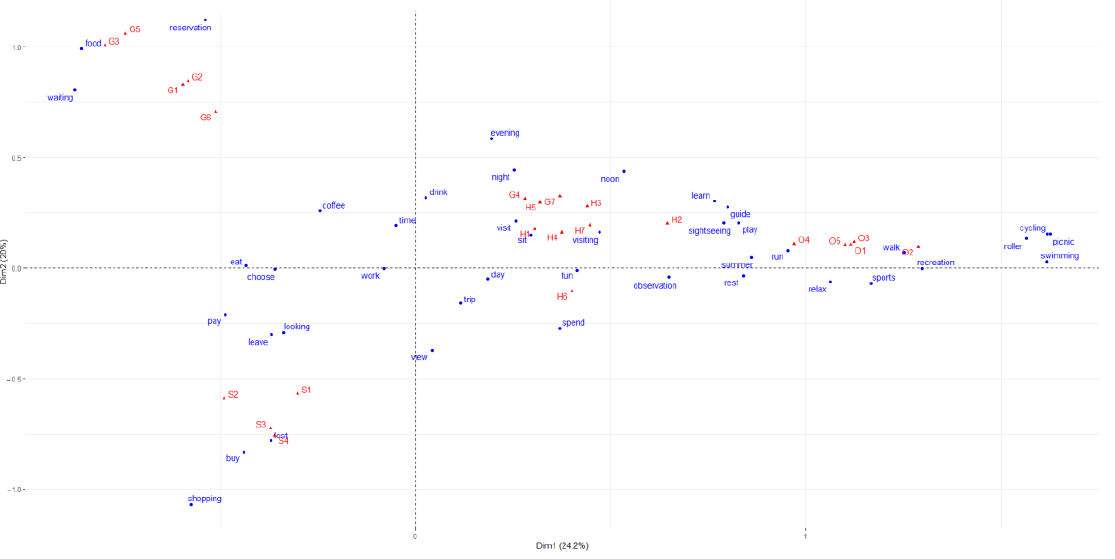
Figure 4. Correspondence analysis of terms associated with place practices dimension and places selected for the study. Red labels represent analyzed places. Blue labels represent keywords associated with shown at the figure place experience dimension. The x -axis and y -axis indicate percent of variance explained.